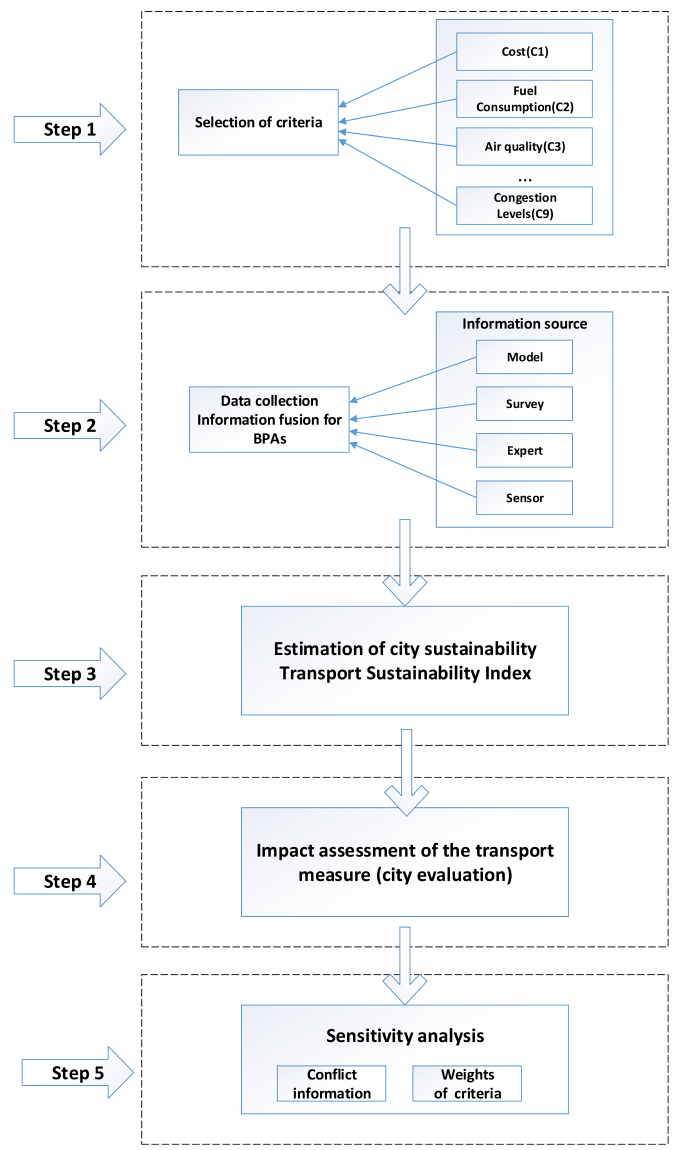
Figure 1. The framework of our proposed method. BPA: basic probability assignment. Step 1: Selection of